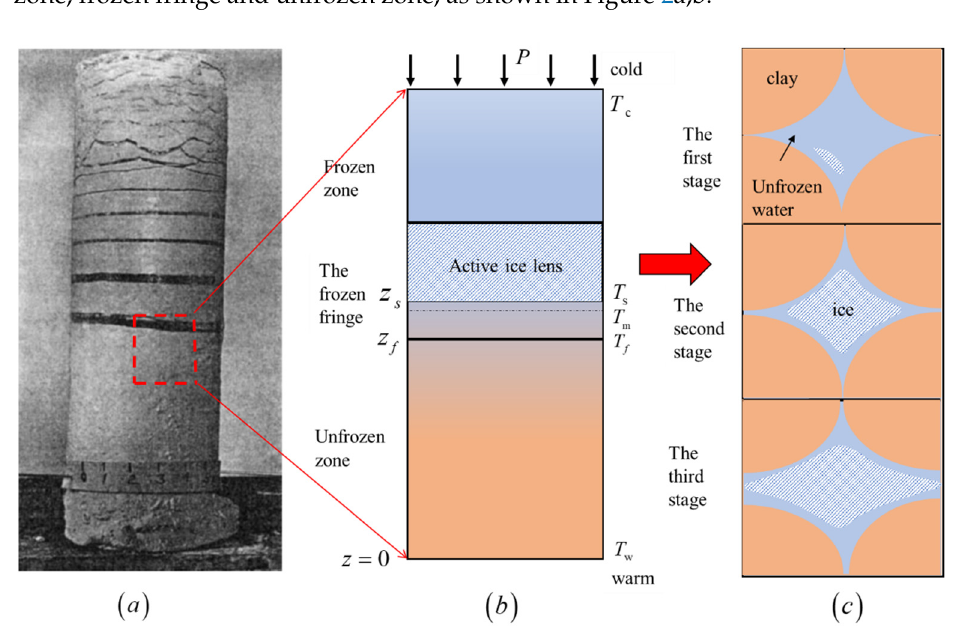
Figure 2. Distribution and growth process model of saturated clay ice lens. ( a ) showing ice lenses that developed in a one-dimensional freezing experiment performed by Taber. The picture adapted with permission from Ref. [2]. 1930, Taber. More details on “Copyright and Licensing” are available via the following link: https://doi.org/10.1086/623720; ( b ) is a schematic diagram of the growth of one-dimensional frozen soil ice lens; ( c ) is the model of the growth process of saturated clay ice lens. Where: P is the external pressure; T c is the freezing temperature at the cold end; T w is the freezing temperature at the warm end; T s is the temperature of the warm end of the active ice lens; T f is the freezing temperature; T m is an absolute temperature; z s , z f and z = 0 are the corresponding position of T s , T f and T w , respectively.